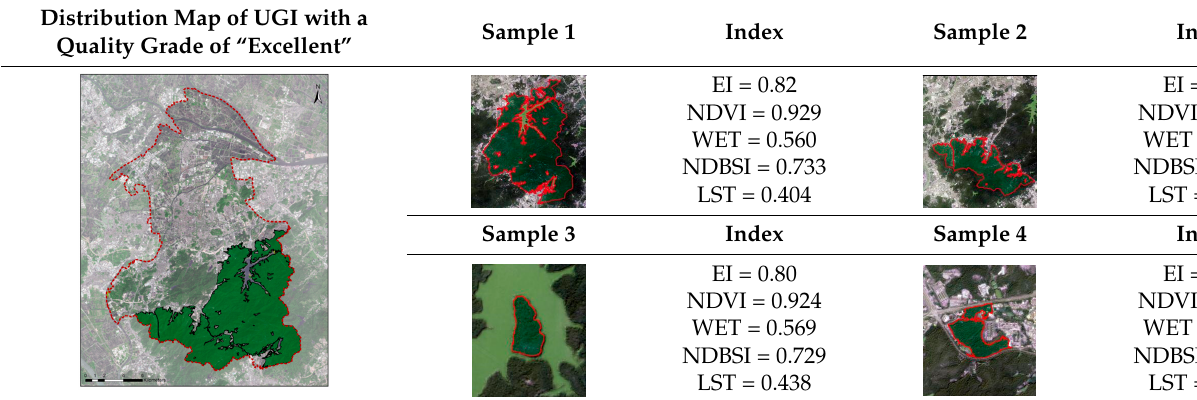
Table 9. Distribution and typical samples of UGI with a quality grade of “excellent”.